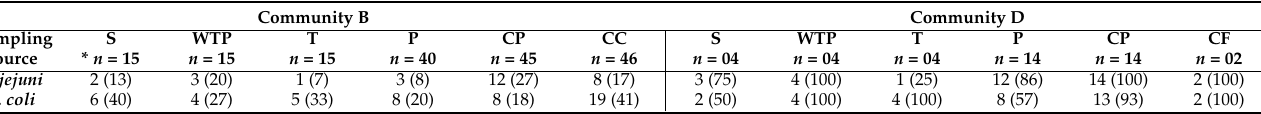
Table 3. Total number (percent) of C. jejuni and C. coli positive samples collected from pre- and post-treatment